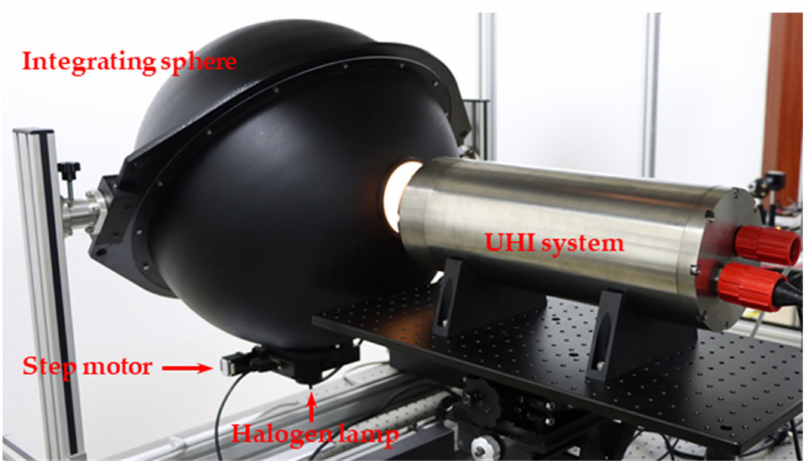
Figure 5. The radiometric calibration instruments of the designed UHI system. The halogen lamp and the integrating sphere (HGISLE500, Hgoan, China) generate uniform light output. A slit driven by the step motor is used to adjust the light intensity, and a radiometer (OHSP-350L, Hopoocolor, China) measures the spectral radiance at the exit port of the integrating sphere.